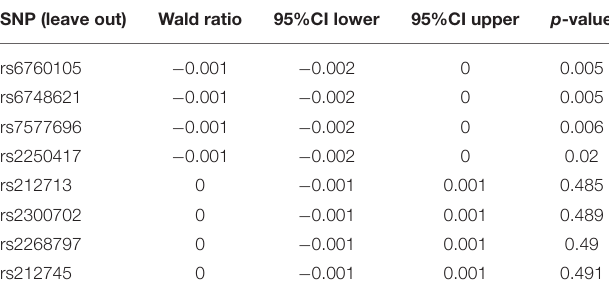
TABLE 2 | Results based on leave-one-out validation.